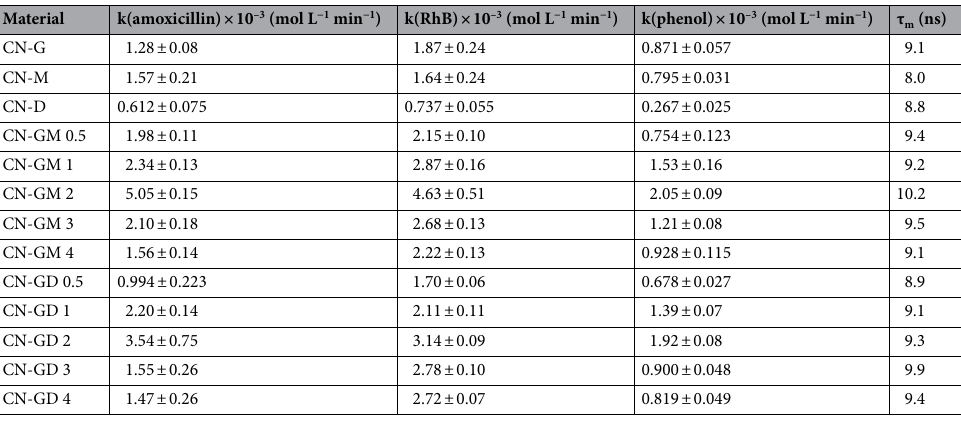
Table 5. Kinetic constants for the degradation of amoxicillin, RhB and phenol and mean decay times of CN materials.